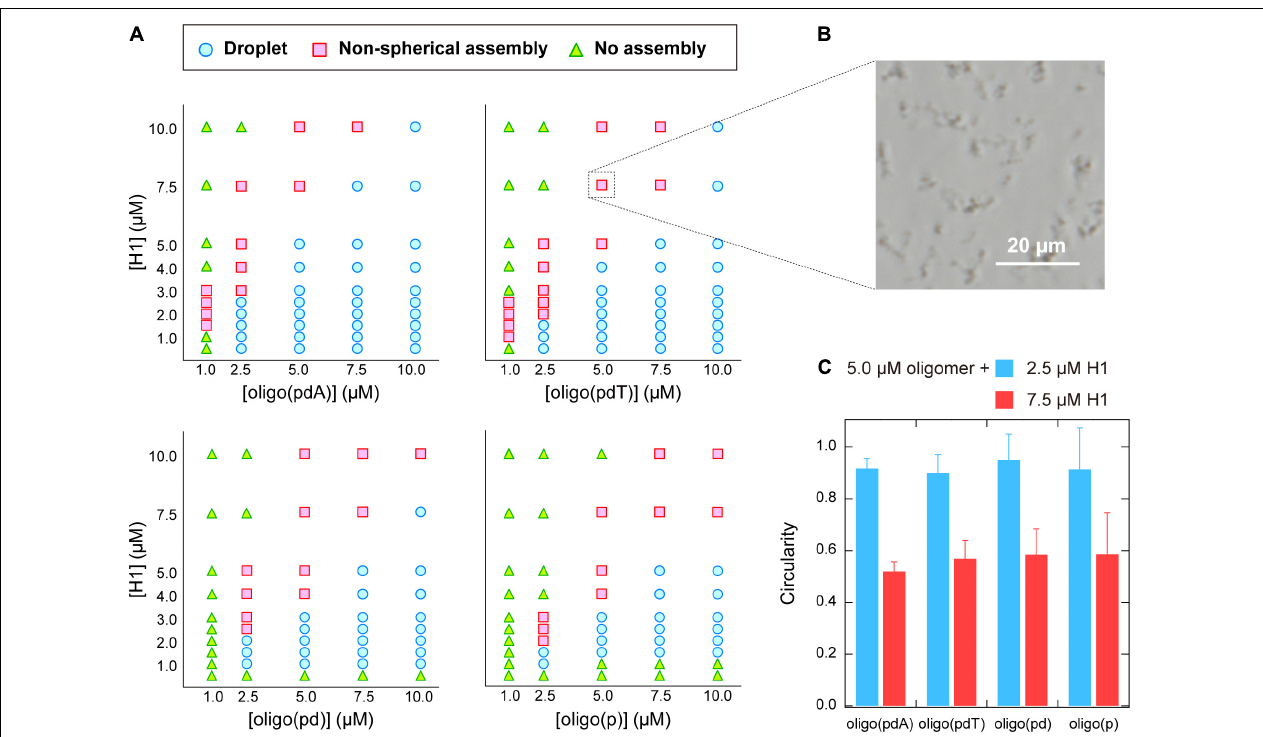
FIGURE 3 | (A) Phase diagrams of aqueous mixtures of oligomers and H1. (B) Phase-contrast microscopy image of typical non-spherical assemblies; 5.0 µ M poly(pdT) and 7.5 µ M H1; scale bar = 20 µ m. (C) Circularity of the assemblies formed in solutions containing 5.0 µ M oligomer and 2.5 or 7.5 µ M H1. The values were obtained by analyzing the fluorescence microscopy images of the solutions under the indicated conditions using the image processing software image J